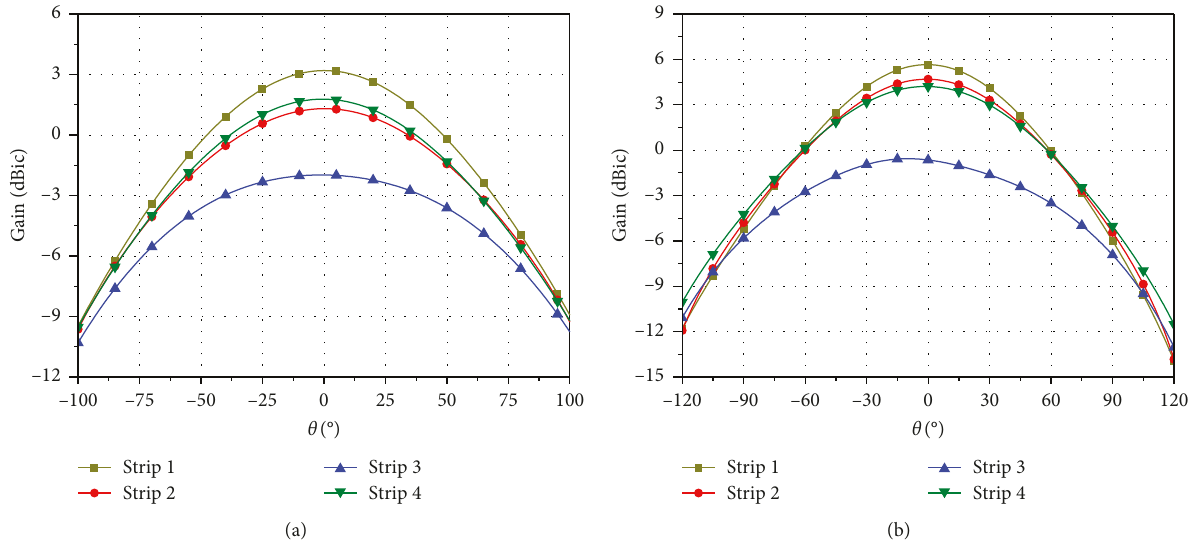
Figure 10: Radiation patterns for different numbers of gaps. (a) 1.207GHz. (b) 1.561 GHz.